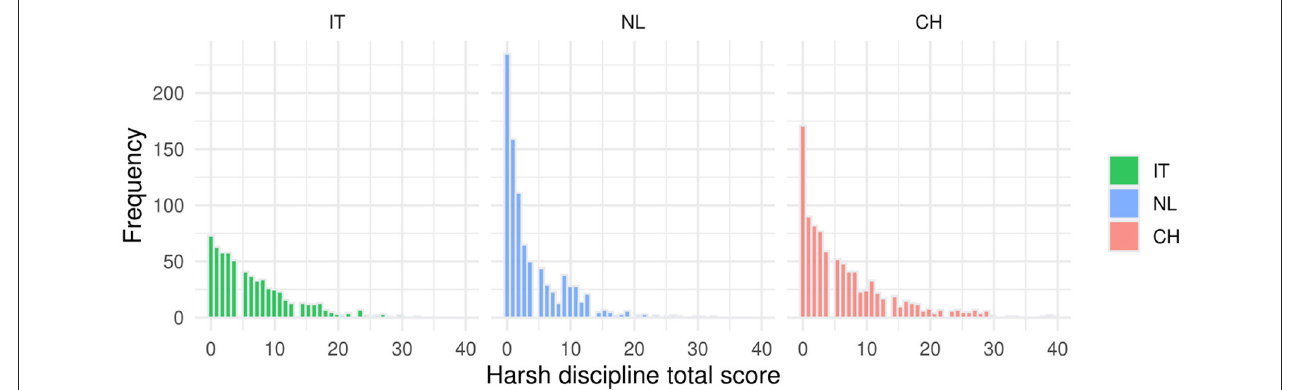
FIGURE 2 | Harsh discipline total score distributions for Italian, Dutch and Chinese mothers.